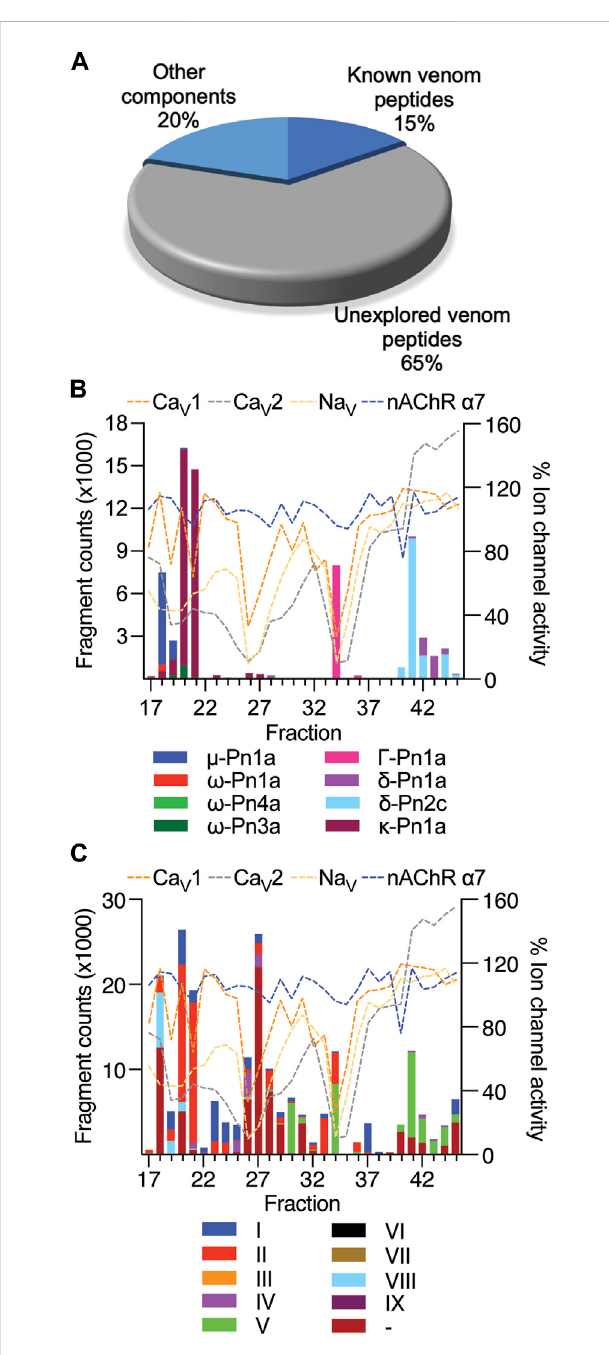
FIGURE 3 Estimated levels of peptide/protein venom components identi fi ed in fractions F17 to F45, and their respective bioactivity at Na V and Ca V channels and the nAChR- α 7. (A) Proportion of known and unknown venom peptides and other venom components detected in this study. (B) Venom peptides with previously reported bioactivity